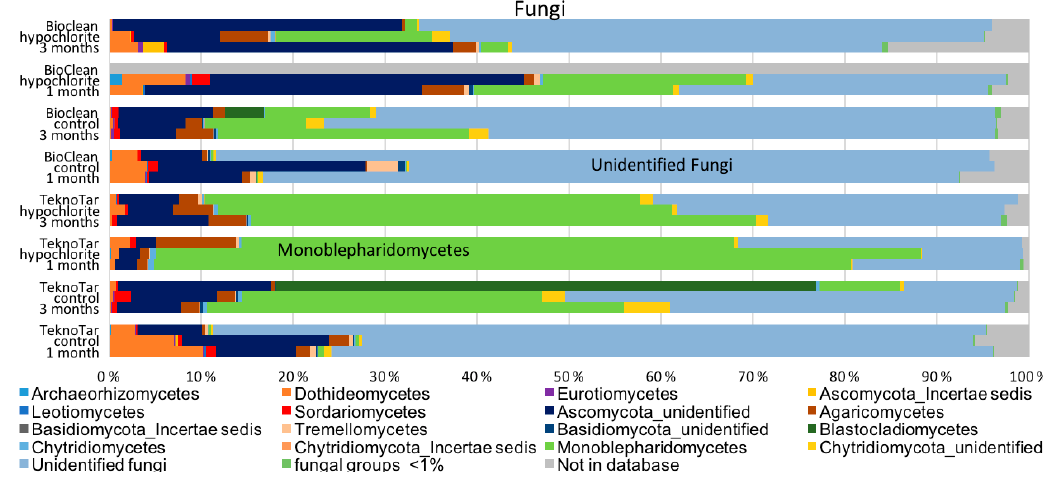
Figure 10. The fungal community composition on surfaces of BioCleanEco coating and TeknoTar coating in in hypochlorite ‐ treated cooling water system and in control system.